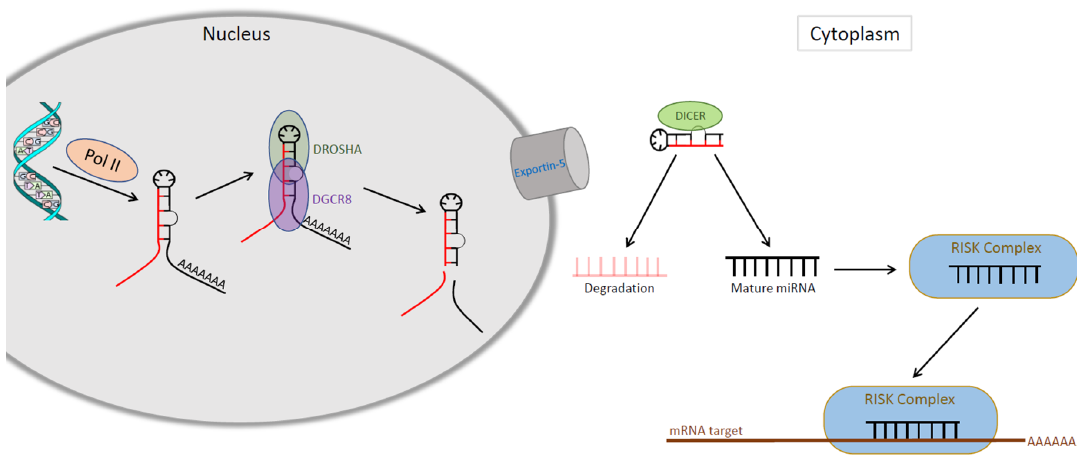
Figure 1. Biogenesis of miRNAs.